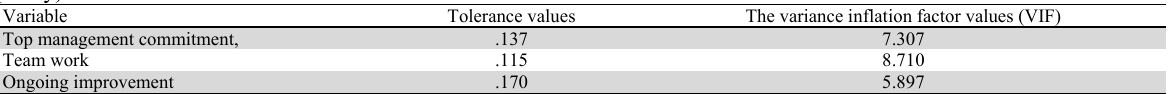
The variance inflation factor values and tolerance values of the dimensions of the dependent variable (i.e. environmental quality)